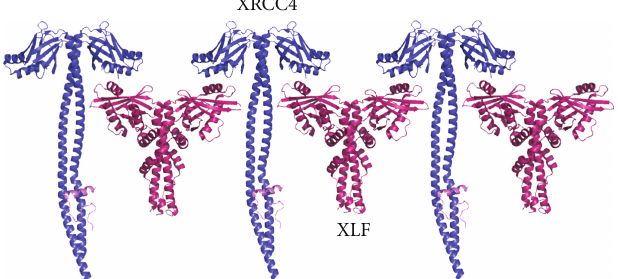
Figure 17: XLF/XRCC4 linear side-by-side interaction model. Adapted from